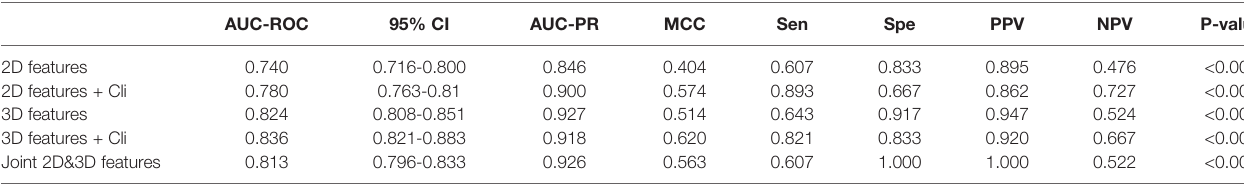
TABLE 3 | Clinical statistics in the independent test dataset.